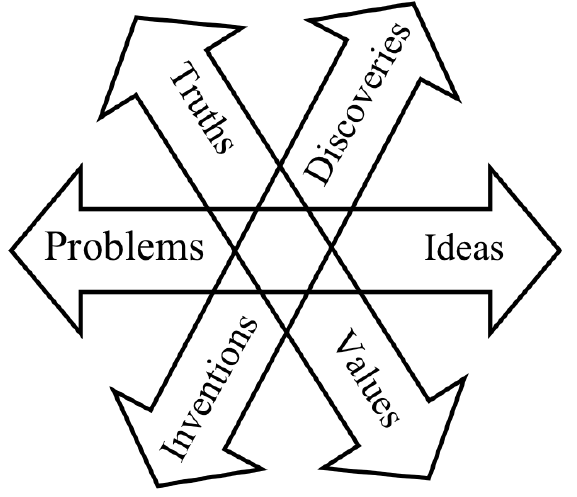
Fig. 1. Illustration of several mutually interdependent aspects of